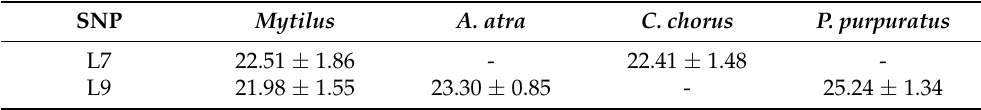
Table 4. Cq values (mean ± standard deviation) for SNPs L7 and L9 in target and non-target species.